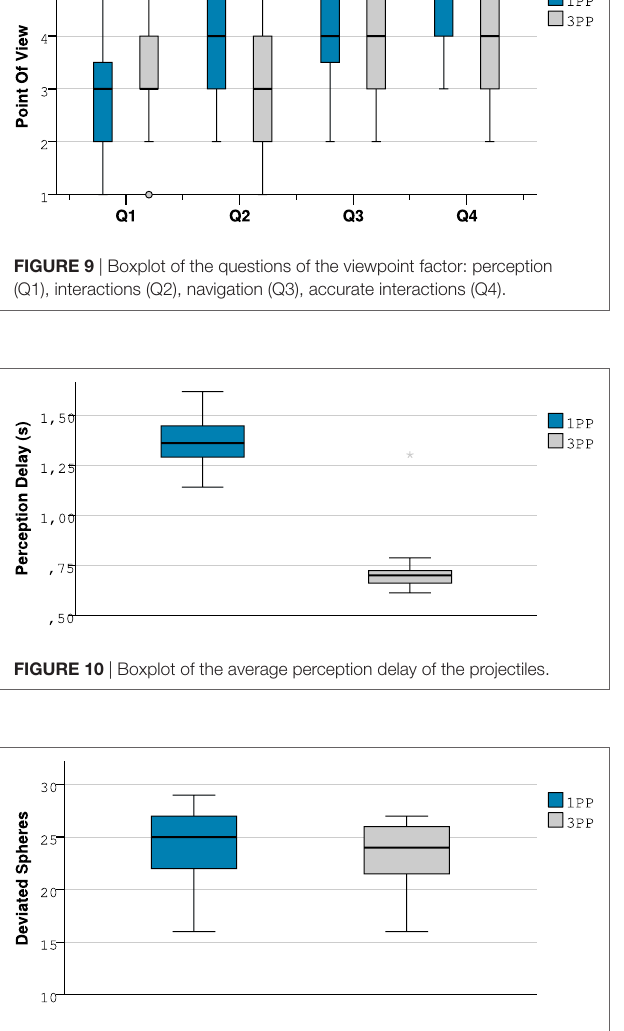
FigUre 11 | Boxplot of the average number of deviated spheres.